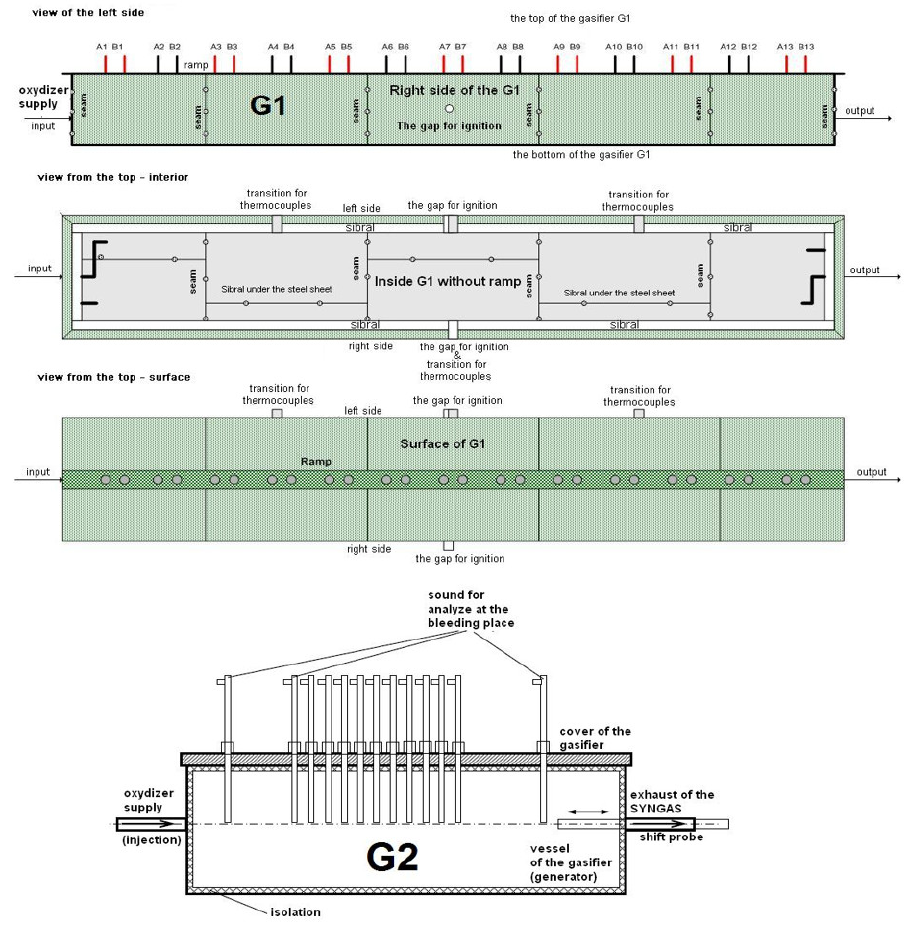
Figure 1. The scheme of the laboratory reactors G1 ( top ) and G2 ( bottom ).